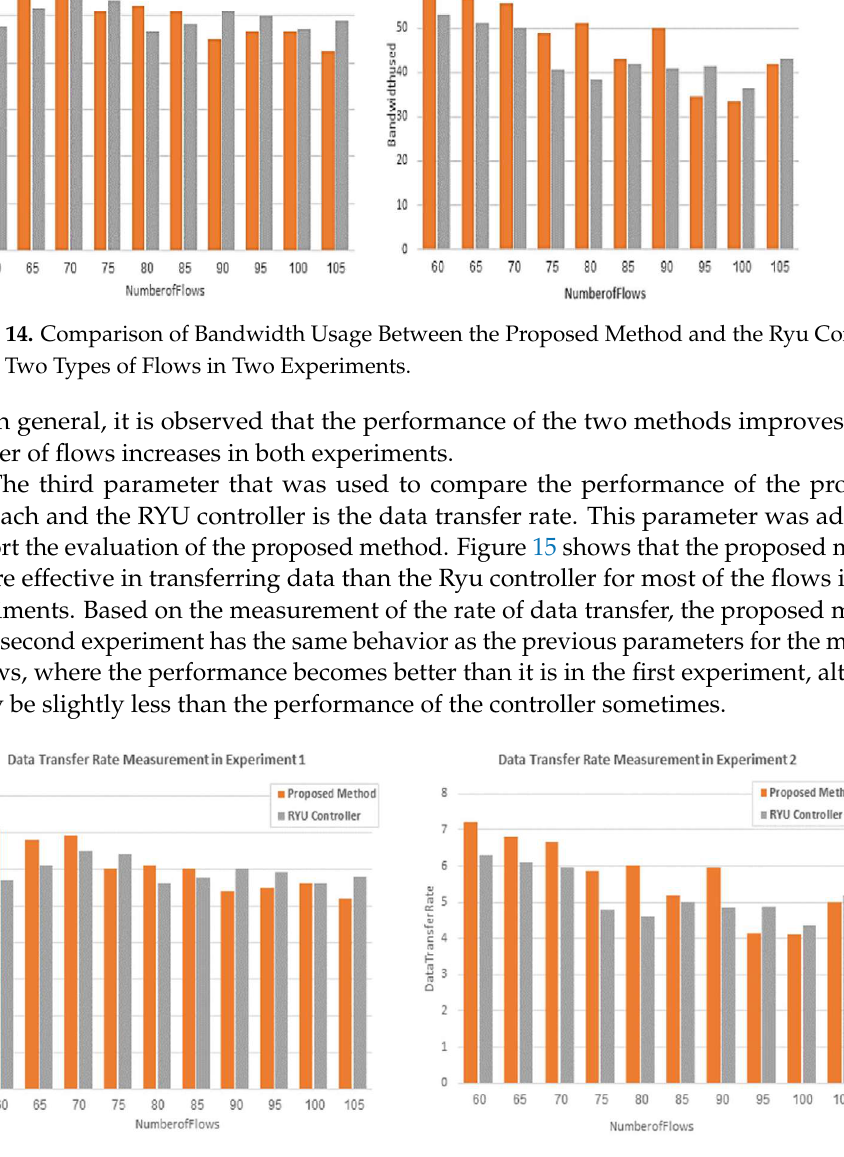
Figure 13. Comparison of Throughput Between the Proposed Method and the Ryu Controller for the Two Types of Flows in Two Experiments.